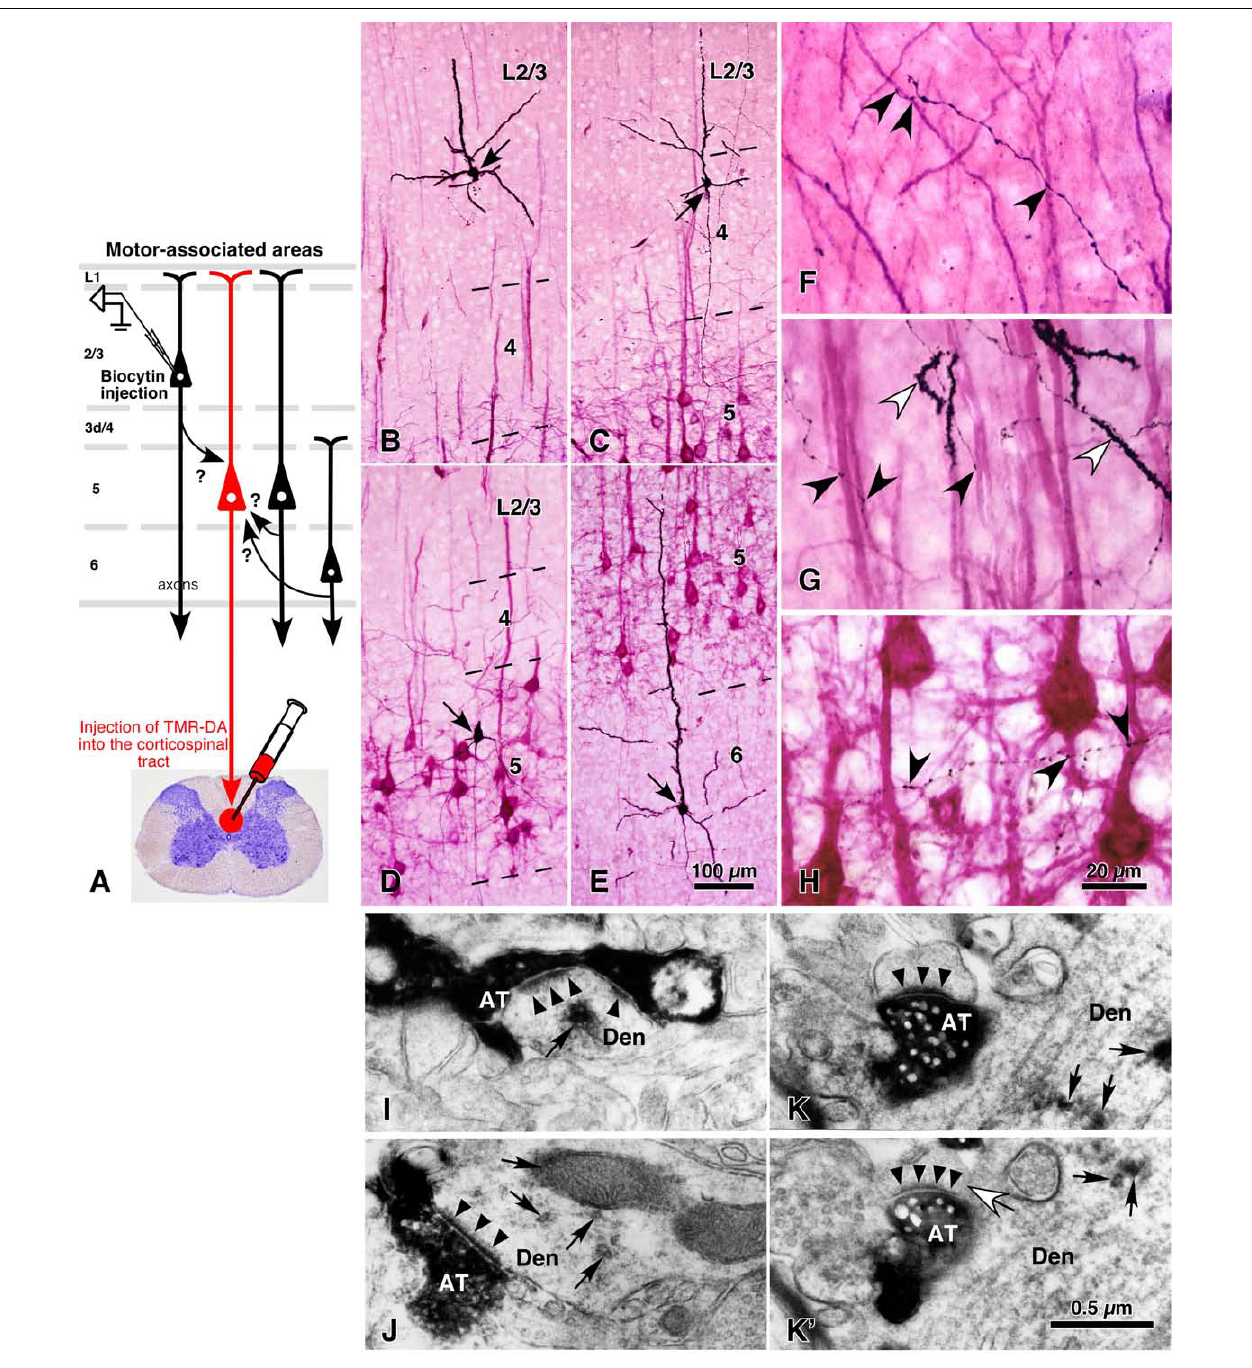
FIGURE 4 | Local excitatory inputs to CSNs in rat cerebral cortex. The dendrites of CSNs in the motor-associated areas were retrogradely labeled in a Golgi stain-like manner by the injection of tetramethylrhodamine-dextran amine (TMR-DA) into the corticospinal tract in the cervical cord with an acidic vehicle ( A ; Kaneko etal., 1996). In 500- μ m-thick cortical slices containing labeled CSNs, pyramidal/spiny neurons were recorded and labeled intracellularly at each cortical layer (arrows in B–E ).The axodendritic appositions between black-labeled axon varicosities and red-visualized dendrites (black arrowheads in F–H ) were quantitatively analyzed. In some